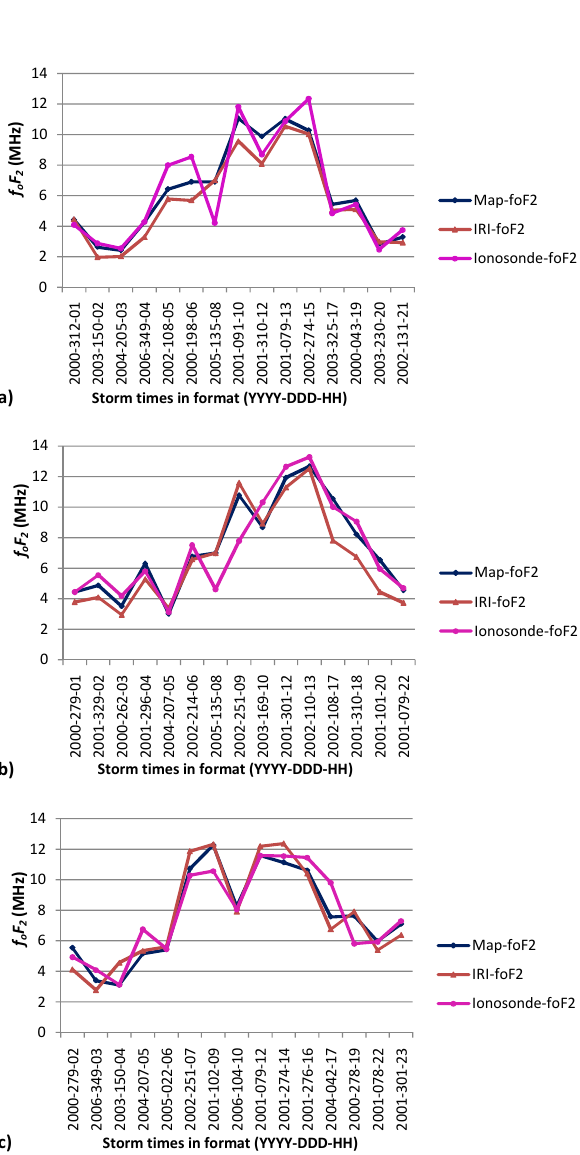
Fig. 7. Comparison of storm time fo F2 values for (a) Grahamstown, (b) Louisvale and (c) Madimbo.